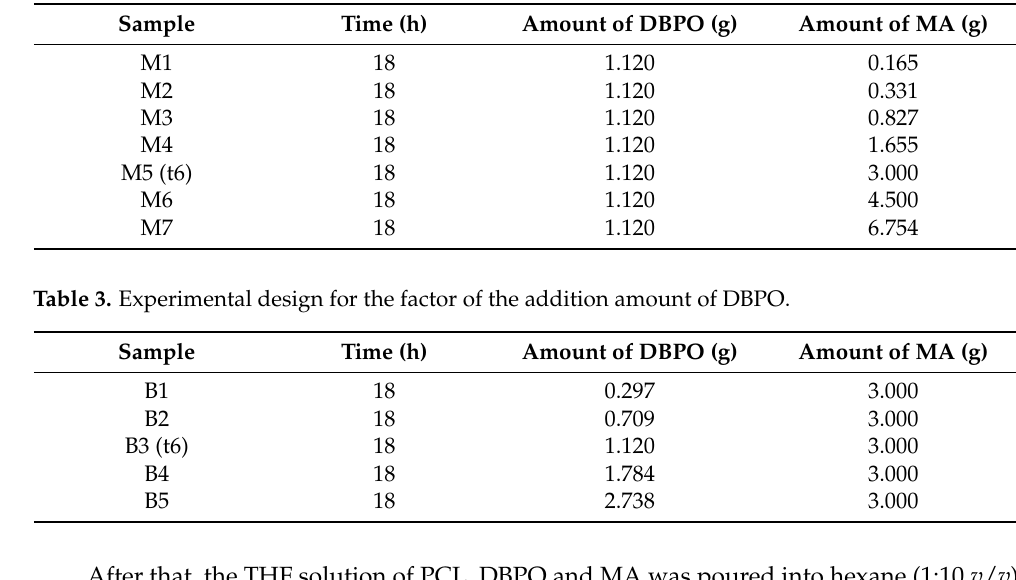
Table 2. Experimental design for the factor of the addition amount of MA.